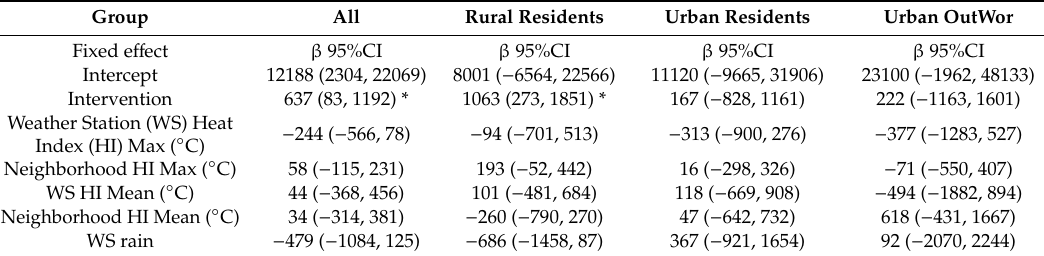
Figure 4. The population mean of individual mean daily steps on baseline days (intervention index = 0) and intervention days (intervention index = 1) in different population groups. The 95% confidence intervals are shown. Table 2. Daily pedometer steps on baselines days and intervention days.